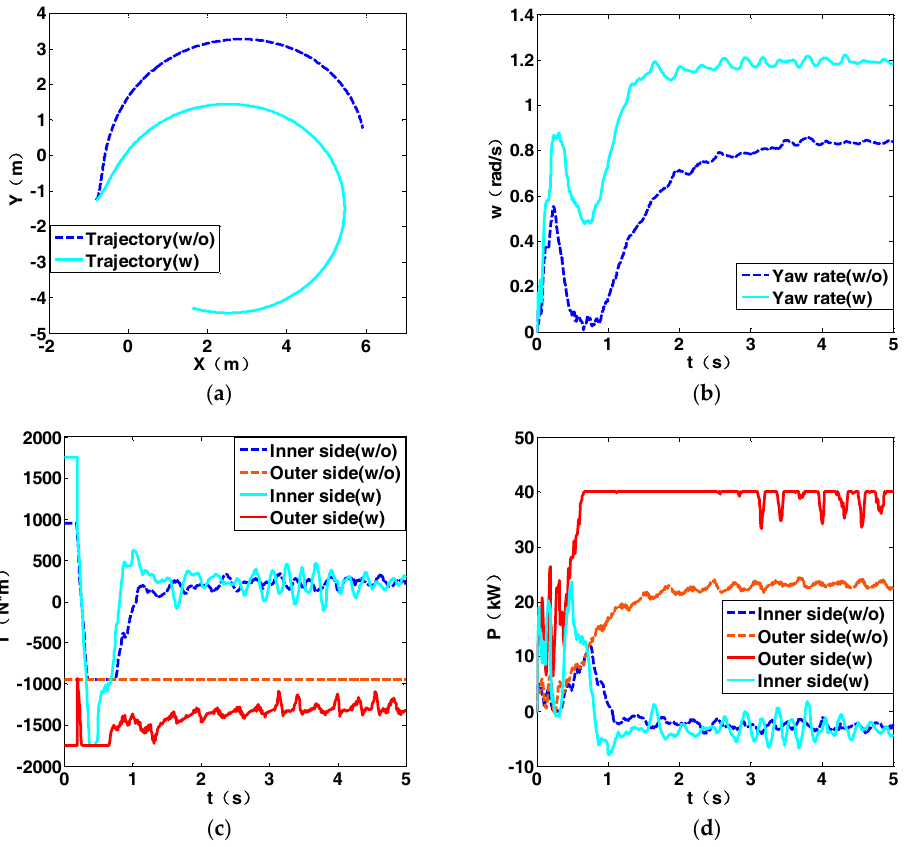
Figure 14. Simulation results of 2 B steering: ( a ) Trajectory; ( b ) Vehicle yaw rate; ( c ) Sprocket torque; ( d ) Sprocket power.